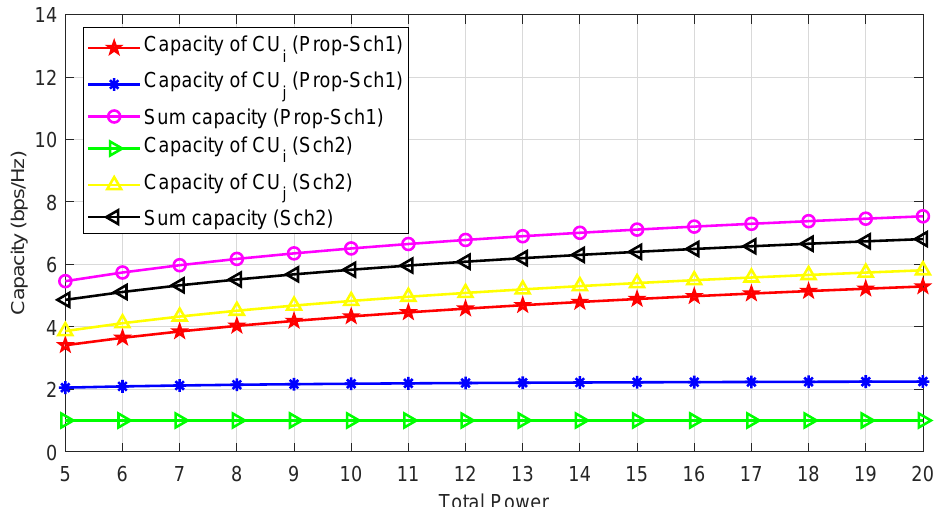
Figure 2. Capacity versus total power of the BS for Prop-Sch1 and Sch2.